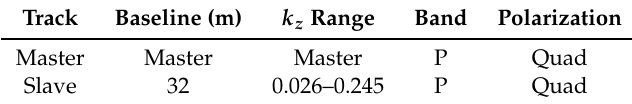
Table 1. The parameters of the interferometric